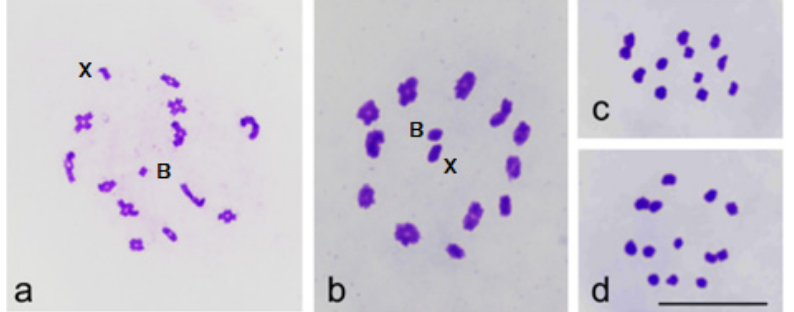
Figure 3. ( a – c ) Male meiosis in C. ledi . ( a ) Diplotene, 12 bivalents and univalent X and B chromosomes. ( b ) Metaphase I, X and B chromosomes in the center of the radial metaphase plate. ( c ) Metaphase II, n = 12. ( d ) Metaphase II, n = 12 + X.